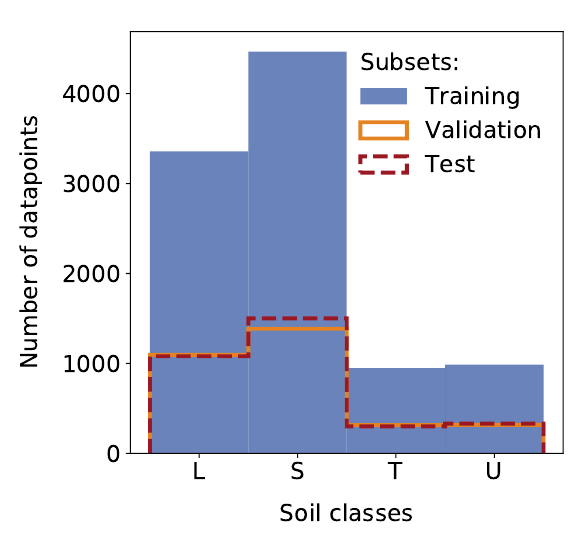
Figure 3. Class distributions of the three datasets: training, valida- tion and